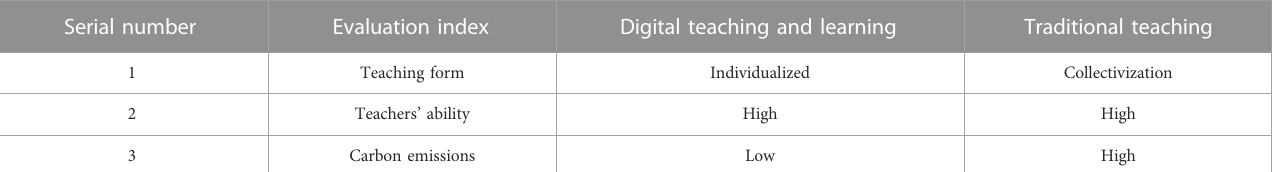
TABLE 1 Comparative analysis of teaching